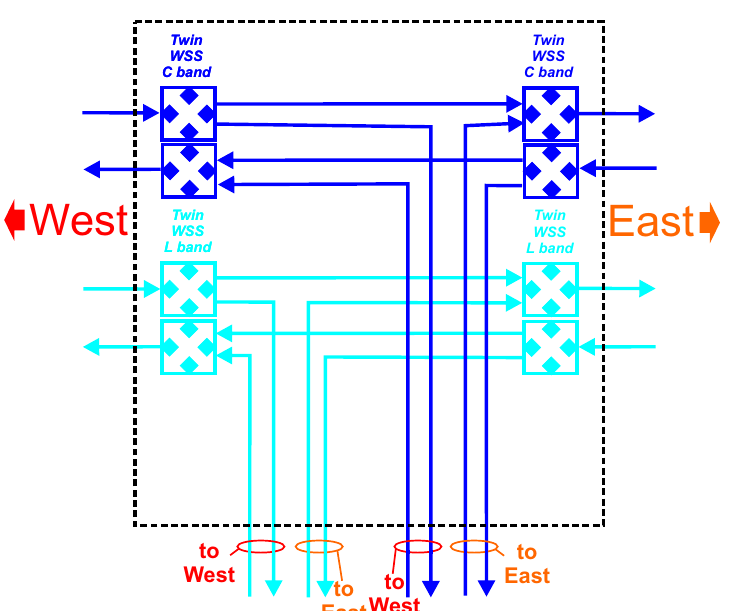
Figure 2. Schematic diagram of Wavelength Selective Switch (WSS) array used in CDC-F ROADM from Figure 2.